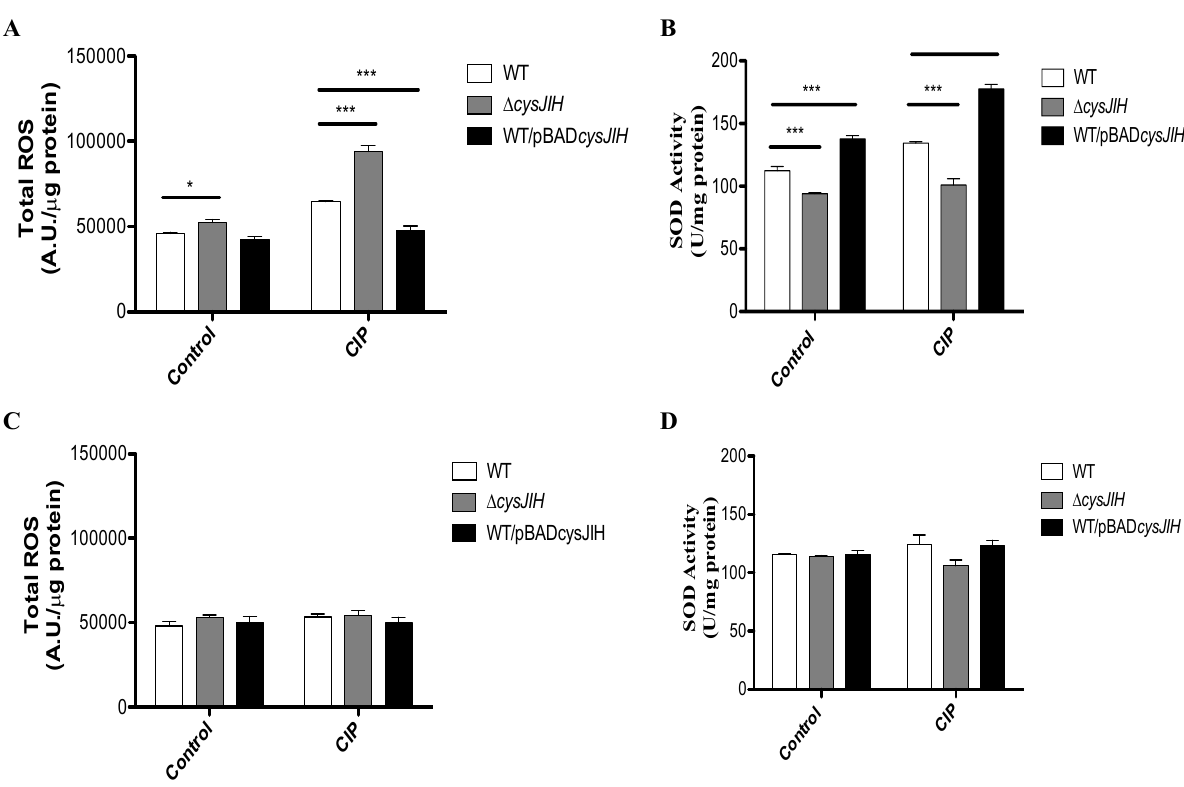
Figure 1. Total reactive oxygen species (ROS) and superoxide dismutase (SOD) activity in S . Typhimurium WT and mutant derivative. S. Typhimurium strains were grown in LB medium to OD 600 0.45 and subsequently cultured in M9 + sulfate ( A , B ) or M9 + cysteine ( C , D ), treated or not with CIP. ( A , C ) total ROS; ( B , D ) SOD activity. For all graphics, white bars: S. Typhimurium WT; grey bars: S. Typhimurium  cysJIH ; black bars: S. Typhimurium WT/pBAD cysJIH . Experiments were repeated six times and asterisks represent statistically significant differences as compared with S. Typhimurium WT in each treatment (* p < 0.05; ** p < 0.01; *** p <